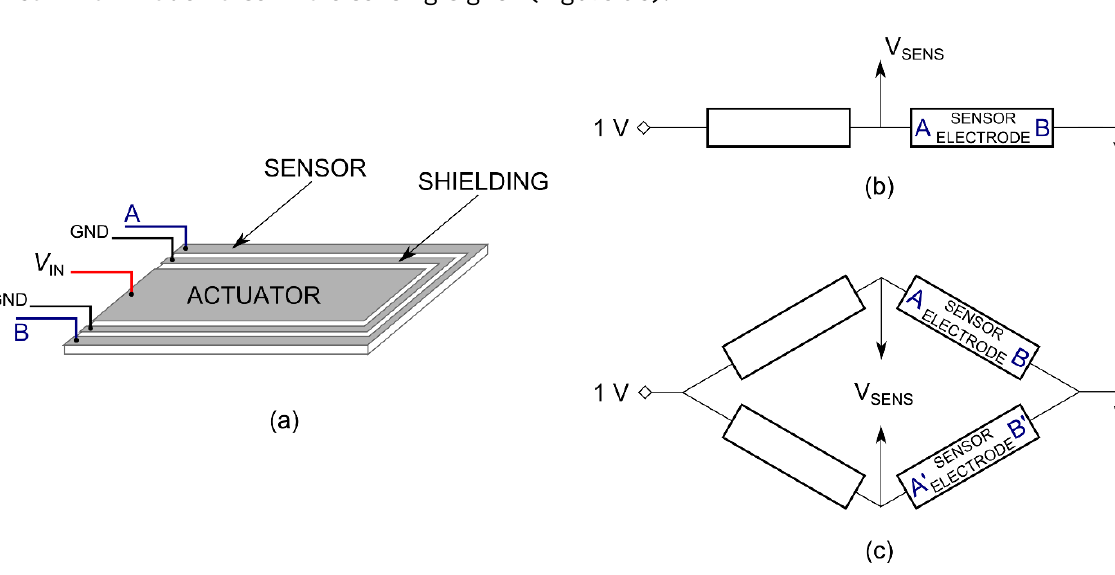
Figure 9. ( a ) Self-sensing IPMC with patterned electrodes and methods for acquiring sensing signal by using ( b ) voltage divider or ( c ) bridge circuits. A’ and B’ denote